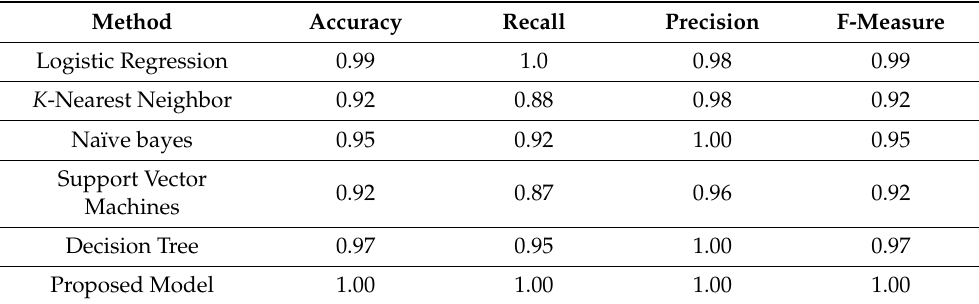
Table 5. Comparative analysis of the proposed model with existing classification techniques on CKD data set.